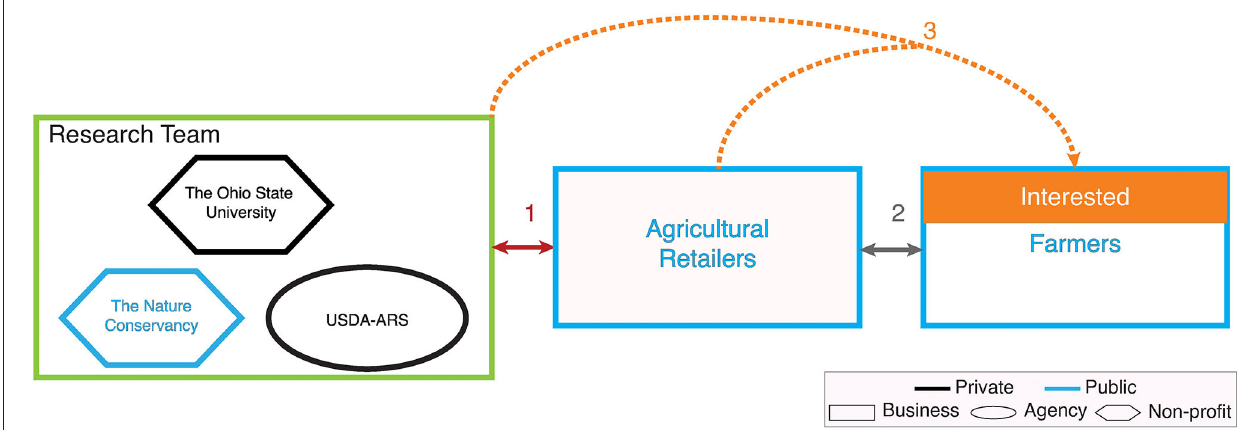
FIGURE 1 | The structure of the Public-Private Partnership. This partnership involved a mixture of public/private businesses, agencies, and non-profit organization (see lower-right legend). The research team included representation from a public, governmental agency; a public, non-profit organization; and a private, non-profit organization. Each number represents the steps in the formation of our public-private partnership. (1) Three agricultural retailers agreed to share their soil test phosphorus data with the research team. (2) The research team then requested the retailers to each contact 25 farmers about their interest in participating with the research project returning information from those who were interested. (3) The research team evaluated only the fields of interested farmers (highlighted orange) and arranged meetings with them and the agricultural retailers to discuss their enrollment in the conservation and monitoring